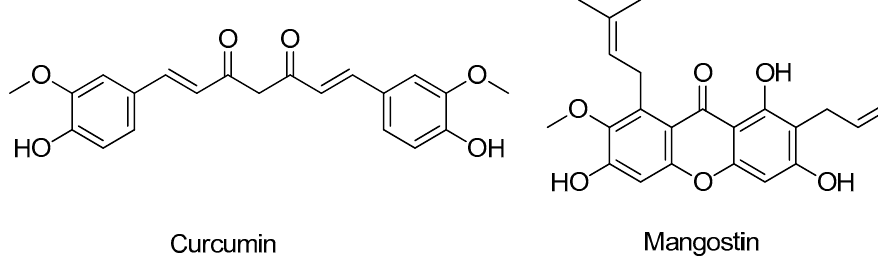
Figure 10. Structures of the studied SIRT inhibitors.